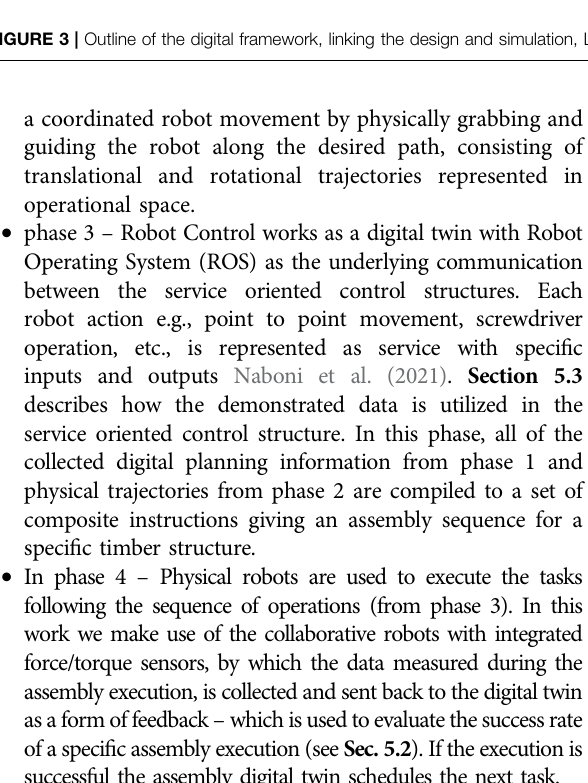
Frontiers in Robotics and AI |